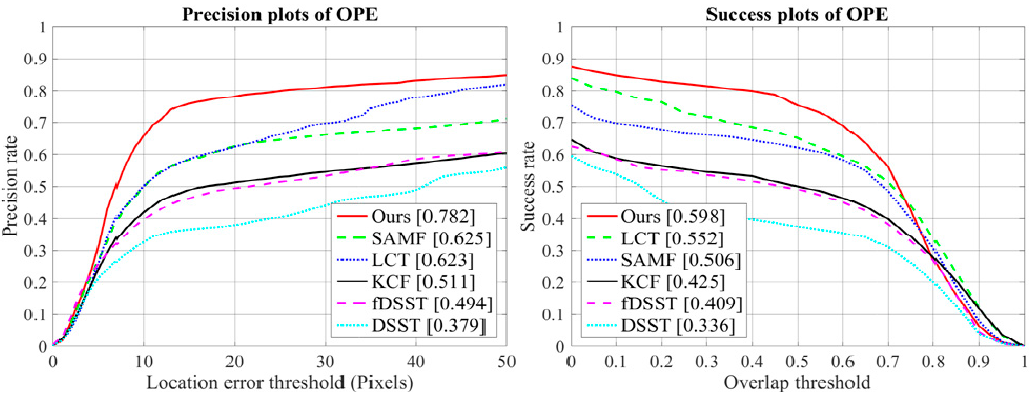
Figure 6. Precision and success plots of the MEEM dataset.